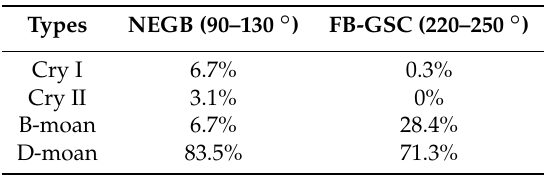
Table 2. Composition of humpback non-song vocalizations from the NEGB and FB-GSC